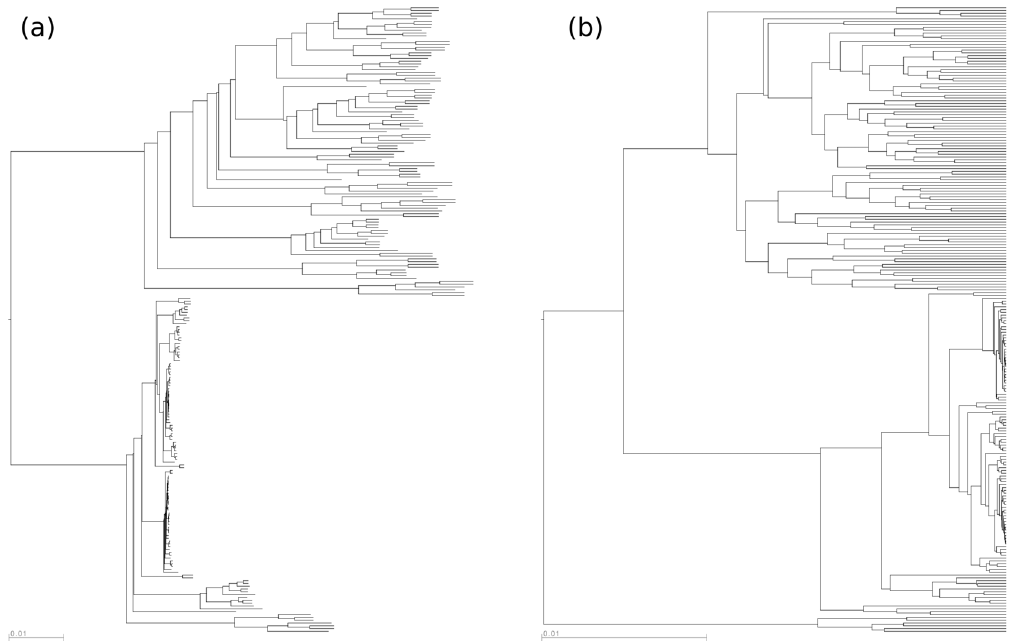
Figure 8. The results of (a) squash clustering and (b) UPGMA as applied to the vaginal data. The labels are not shown and they do not appear in the same order on the two trees. For a comparison of labeled trees, see Supplementary Figure S1.